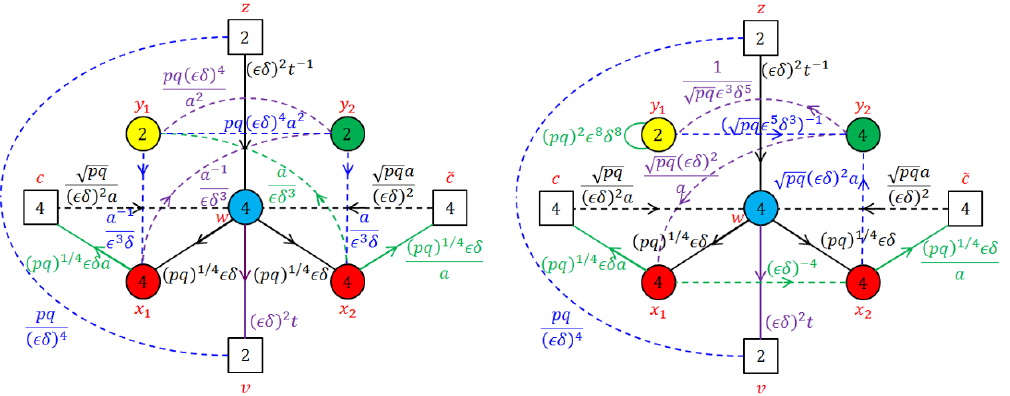
Figure 27 . Quivers of two E-string trinions glued together after several Seiberg dualities. On the right we have the resulting quiver of two S -glued trinions after three Seiberg dualities. We mark in blue the (cid:12)elds we consider as fundamentals and the rest are considered anti-fundamentals of the SU(2) y gauge symmetry (Green) on which we perform the duality. On the left, the resulting 2 quiver after the duality. On this quiver we perform S-duality on the SU(2) y (Yellow). We pick a duality frame where the (cid:12)eld in the fundamental representation of y 2 becomes anti-fundamental, but with the same charges and